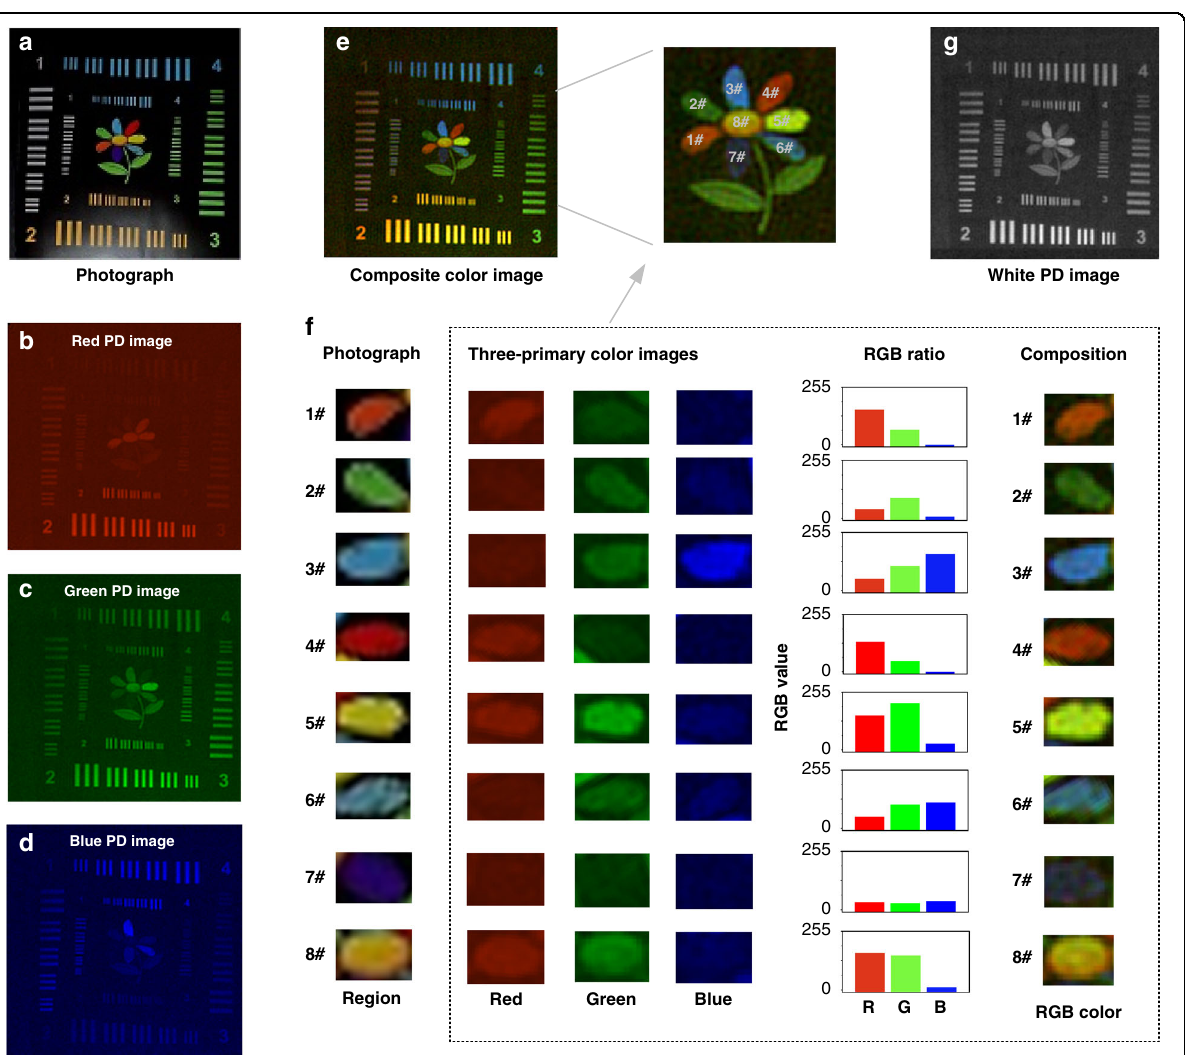
Fig. 4 Demonstration of color imaging under a diffuse light intensity of ~20 μ W cm − 2 . a Photograph of the imaging target. b – d Images by RGB PDs. e Composite color image of RGB PD images. Inset is the enlarged color fl ower petals marked by numbers. f The comparison of each fl ower petals obtained by photograph, individual RGB images, and the fi nal composed color image. g Image by W